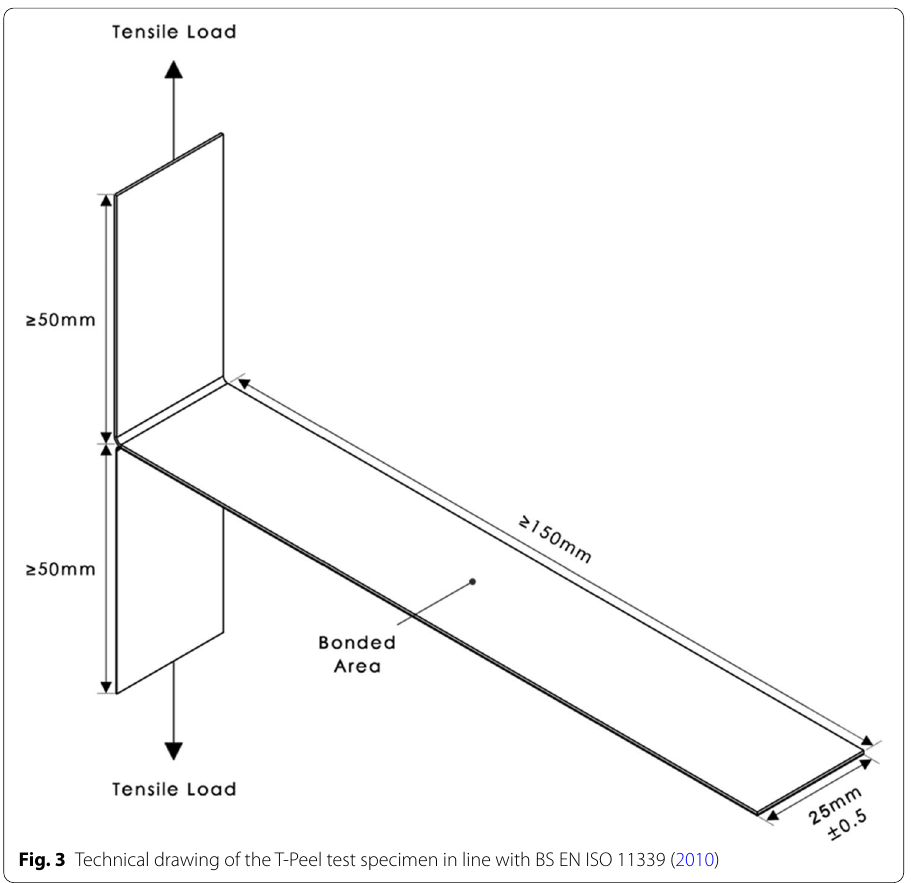
Fig. 3 Technical drawing of the T-Peel test specimen in line with BS EN ISO 11339 (2010)